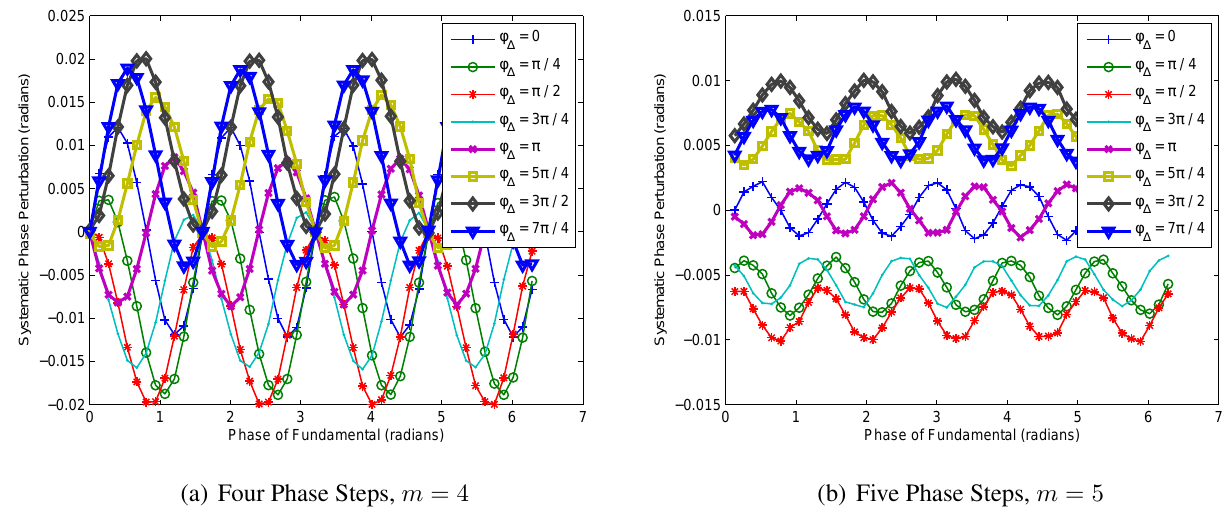
Figure 7. Simulation of the systematic perturbation introduced by non-circularly symmetric error in the complex domain measurement as a function of the phase shift in the correlation waveform, ϕ . f